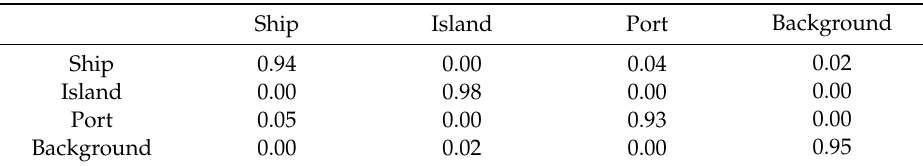
Table 3. Confusion matrix of ship classification.